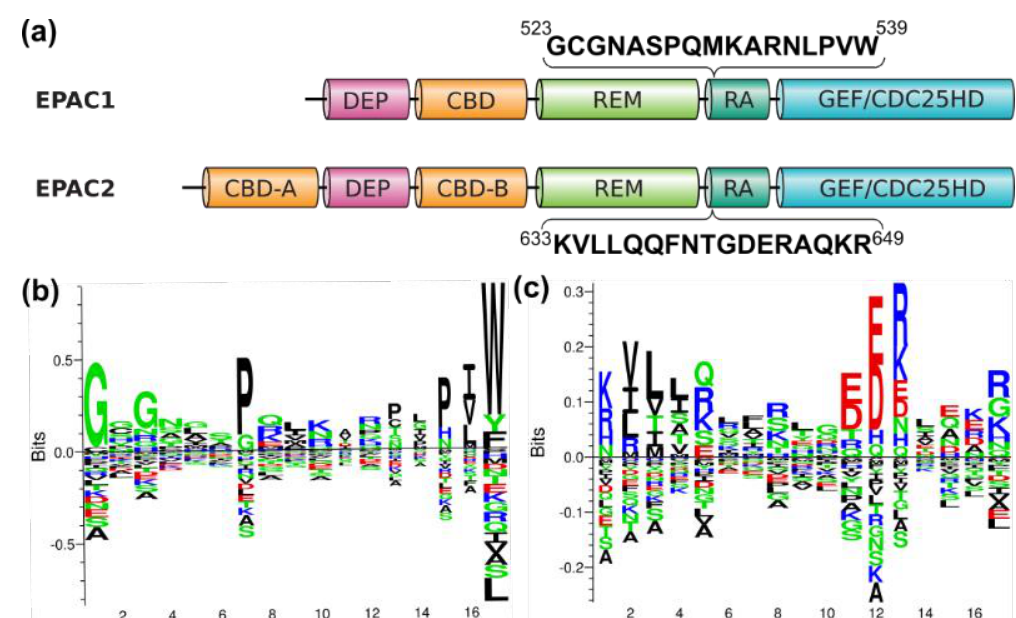
Figure 6. Isoform-specific sequence motifs of EPACs. ( a ) Alignment of human EPAC1 and EPAC2 with sequences spanning the isoform-specific motifs highlighted. Position-specific and isoform specific sequence motifs, with sequence weighting, and two-sided representation of amino acid enrichment and depletion, in EPAC1 ( b ) and EPAC2 ( c ) RA domain.